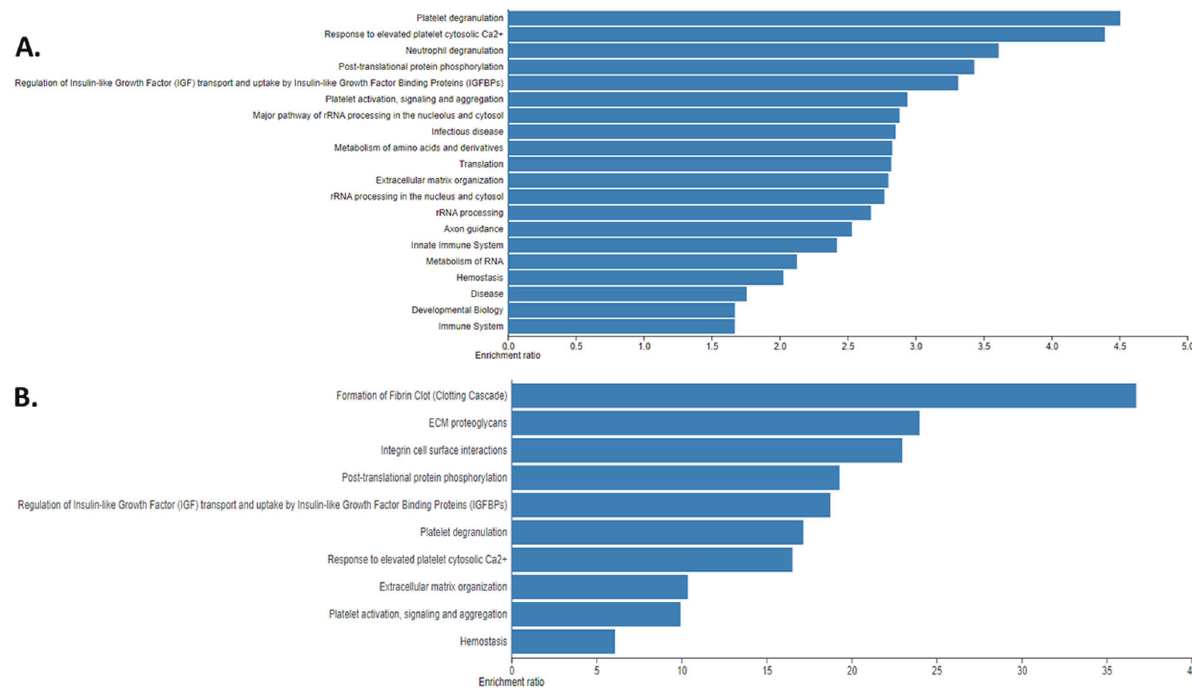
Fig. 1 Overview of the diversity of the bone marrow bone proteome. A WebGestalt analysis of all proteins identi fi ed across all samples using the Reactome pathway and presenting the top 20 pathways. B WebGestalt analysis of the top 5% most abundant proteins. (top 10 pathways).